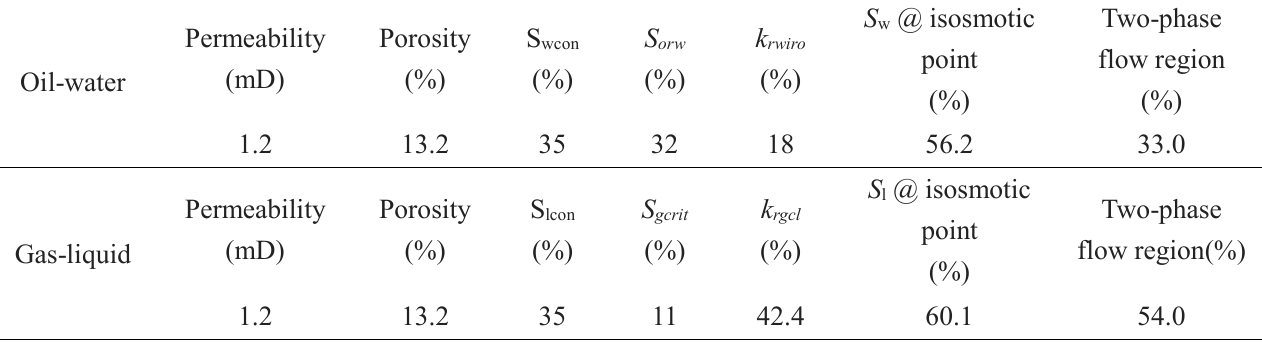
Table 4—Relative permeability of low permeability